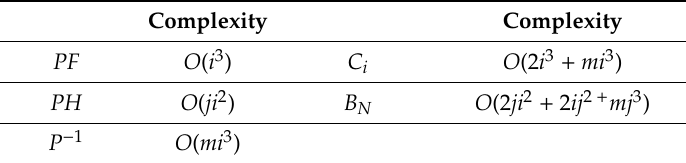
Table A1. The complexity of matrix